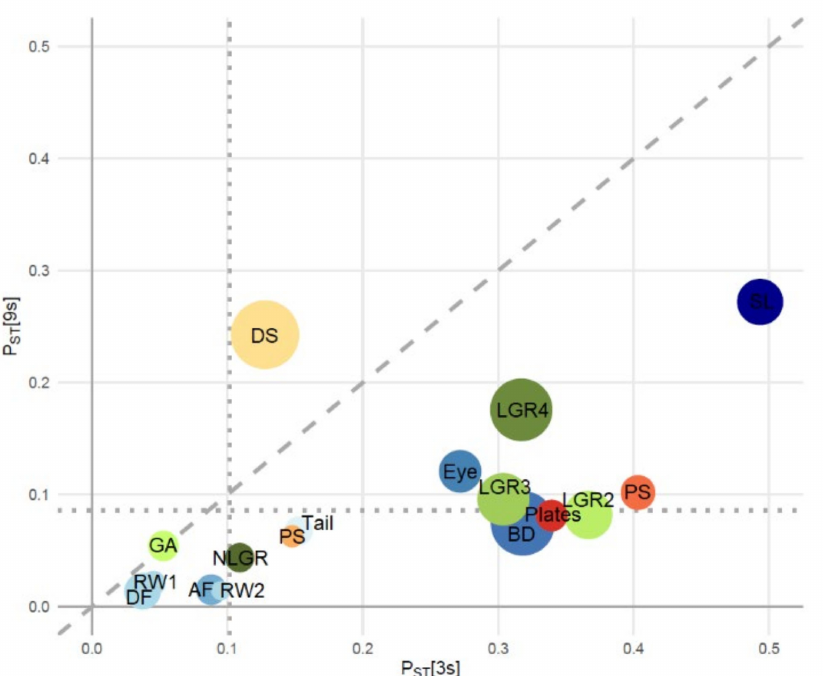
Figure 2. Levels of phenotypic differentiation ( P ST ) among three-spined ([3s]) and nine-spined ([9s]) stickleback populations for 17 morphological traits (see Section 2.2 for description of trait codes), with the diagonal dashed line representing the 1:1-line. The dotted vertical and horizontal lines represent the level of neutral genetic divergence in [3s] ( F ST = 0.102) and [9s] ( F ST = 0.086), respectively. Circle sizes indicate the importance of parallel versus non-parallel effects. These effect sizes were determined using ANOVAs attributing the variation in each trait to the effect of site (degree of parallelism), the effect of species, and the effect of site by species interaction (degree of non-parallelism). Shades of red-orange , blue and green represent traits related to body armour, body shape and gill morphology, respectively.